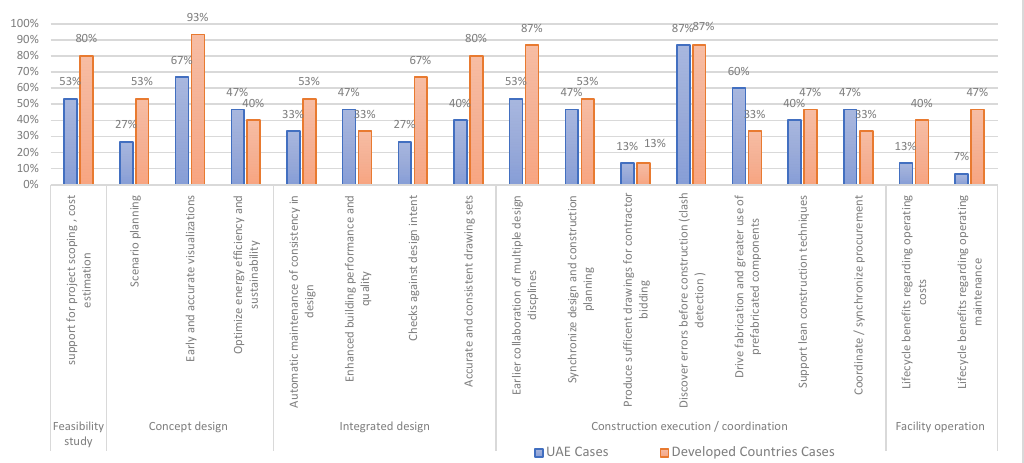
Figure 4. BIM benefits gained during the whole LC (BIM process).